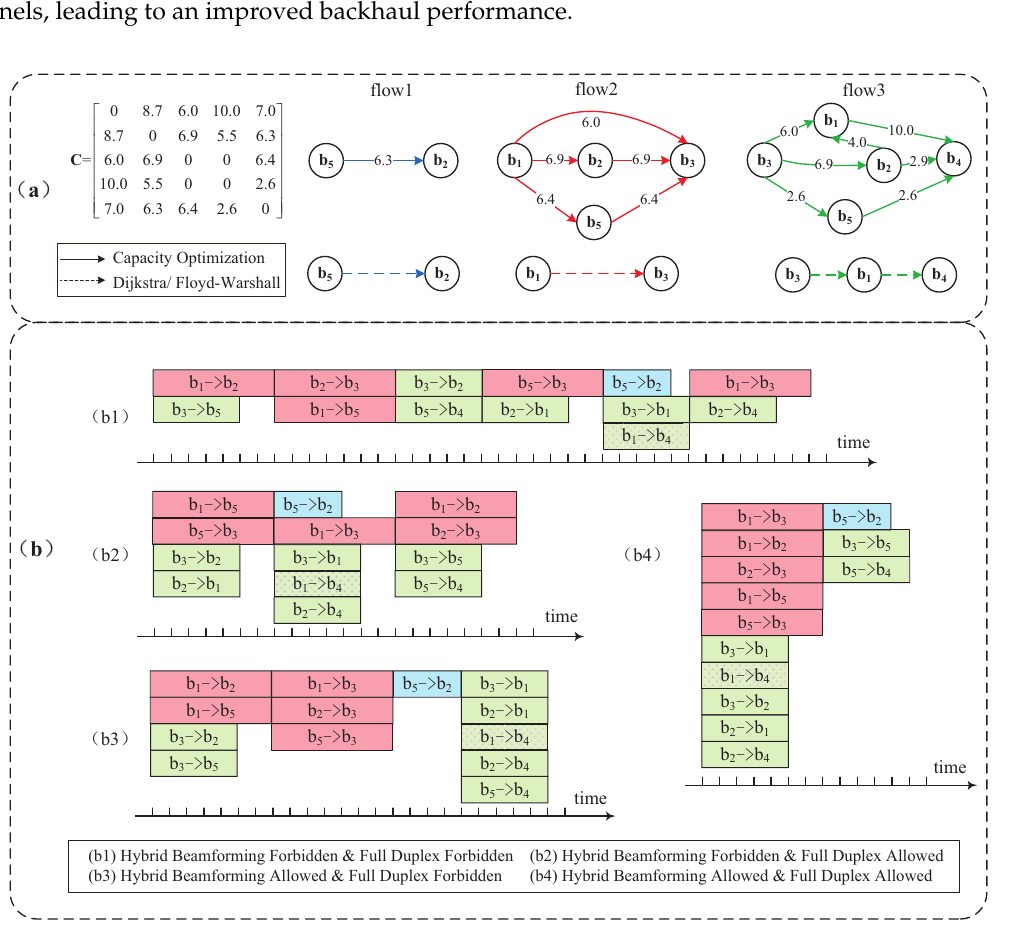
Figure 4. ( a ) Routing results of the shortest path algorithm and the capacity optimization method in the mm-wave backhaul network; and ( b ) the scheduling scheme in four scenarios based on the optimization routing results in ( a ) in a mm-wave backhaul